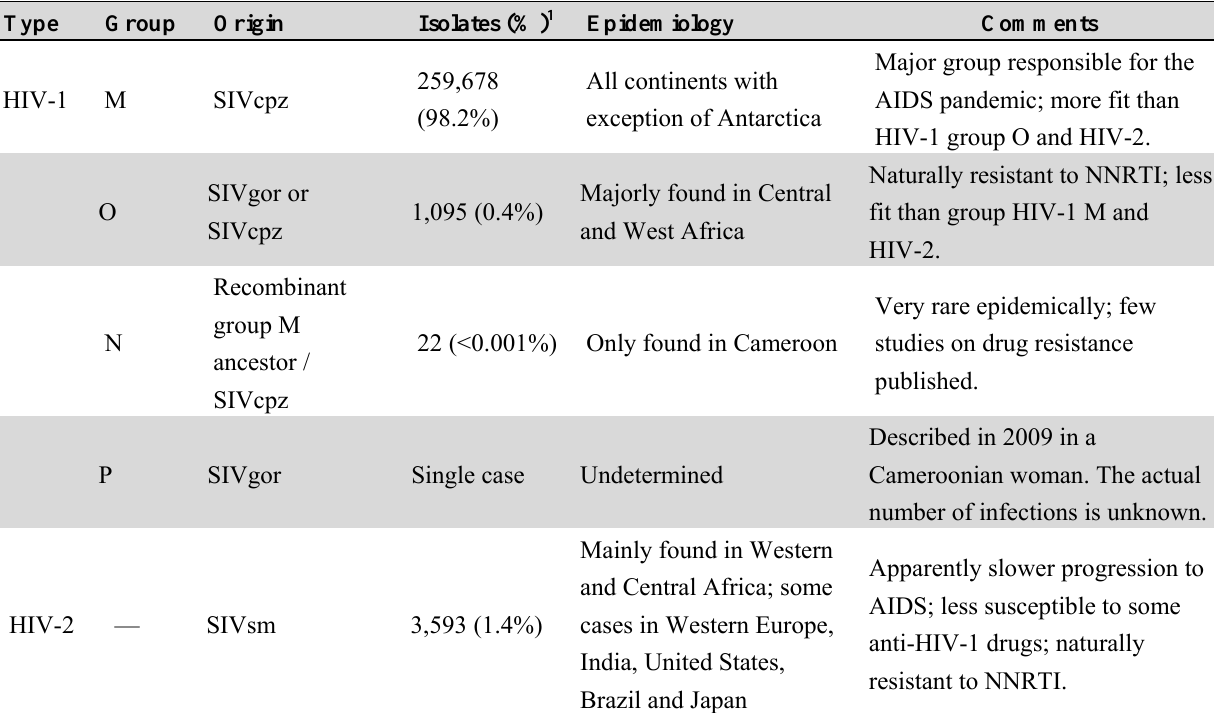
Table 1. Summary of HIV types and groups.